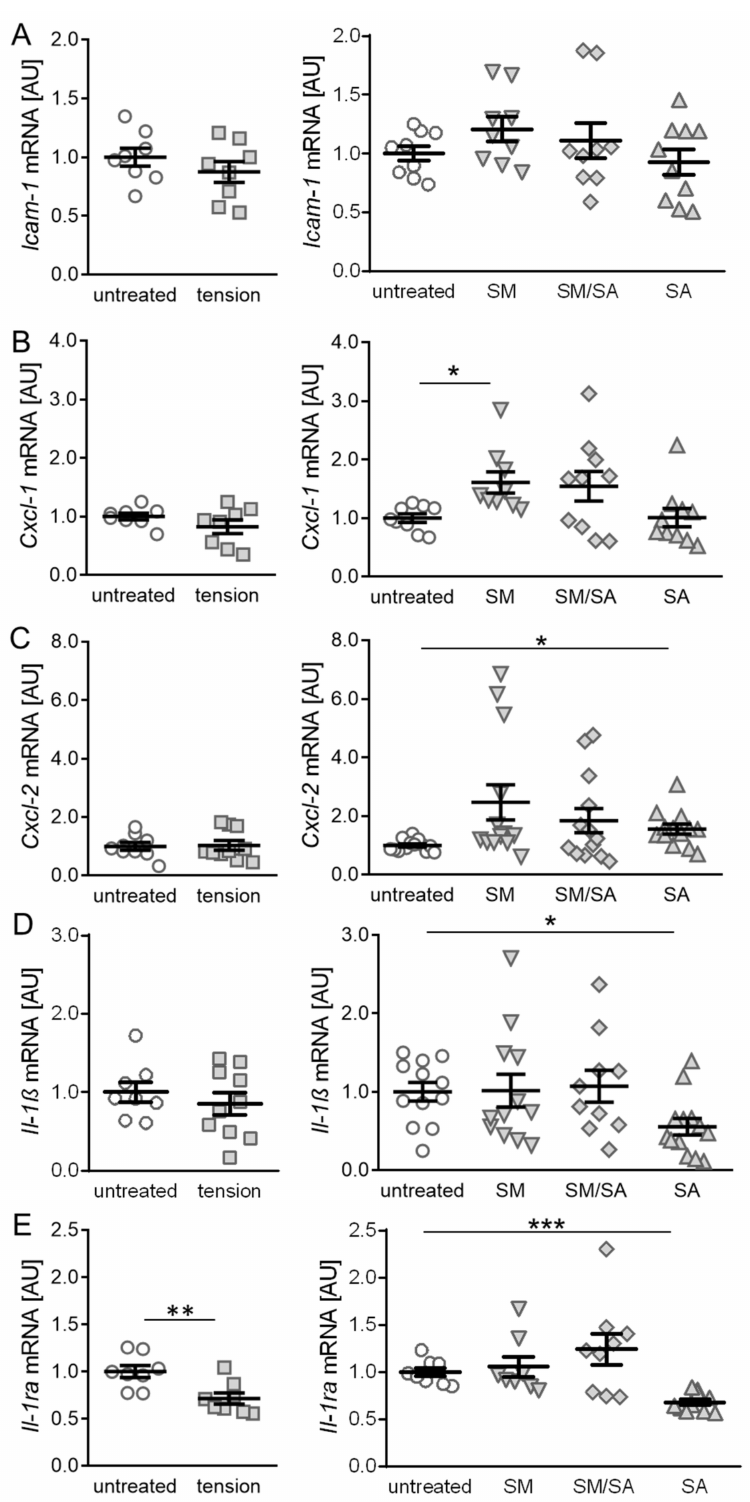
Figure 3. Effects of different tensile loading protocols on genes involved in the immune cell recruit- ment. The relative gene expression of Icam-1 ( A ), Cxcl-1 ( B ), Cxcl-2 ( C ), Il-1ß ( D ), and Il-1ra ( E ). AU: Arbitrary units; SM: Moderate; SM/SA: Intermediate; SA: Advanced. n ≥ 5, * p ≤ 0.05, ** p ≤ 0.01, *** p ≤